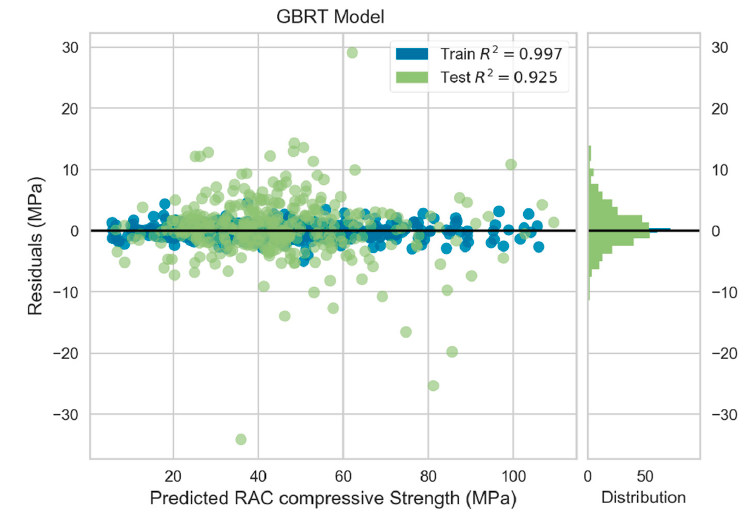
Figure 9. Residuals plot for GBRT model.